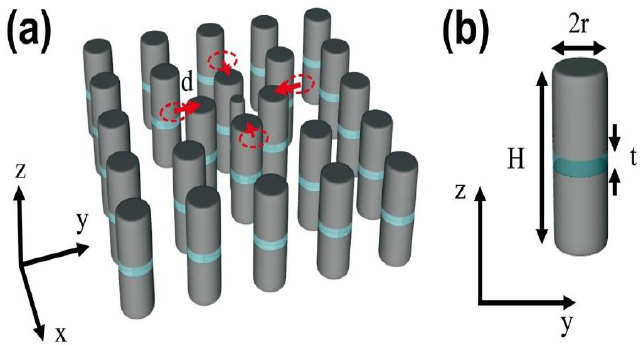
Figure 1. ( a ) Schematic diagram of the proposed photonic crystal (PhC) cavity consisting of 19 × 19 square lattice of cylinders; ( b ) In each cylinder with a radius of r and total height of H , a thin SiO 2 layer, indicated in cyan, with a thickness of t is sandwiched between thick Si layers. The central hole has a smaller radius of r d , and the four nearest neighbor rods are shifted into the center over a distance of d from their original positions, as denoted by red dotted circles.